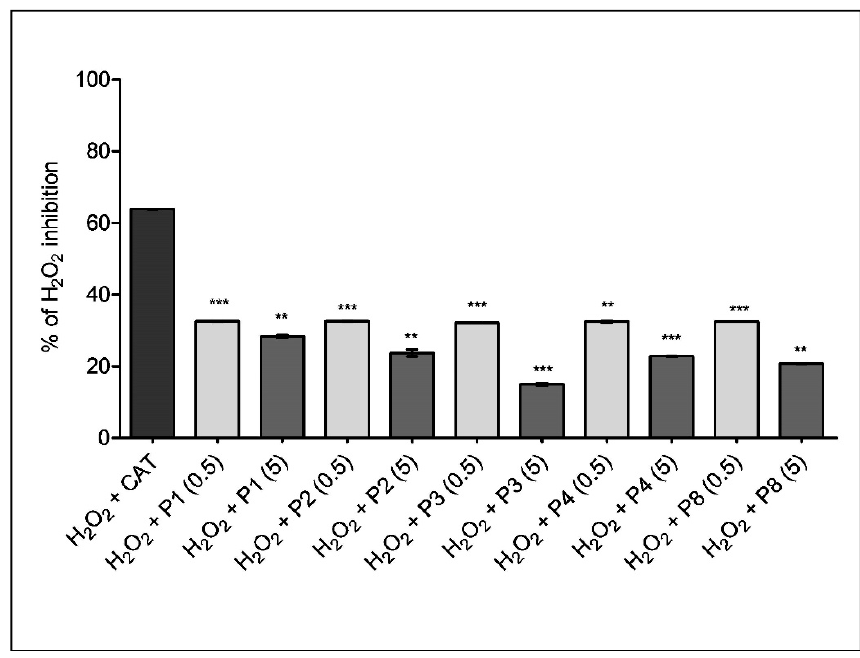
Figure 8. FOX assay for samples P1, P2, P3, P4, and P8 applied in 2 concentrations, 5 mg/mL and 0.5 mg/mL (** p < 0.01, *** p < 0.001 vs. CAT).